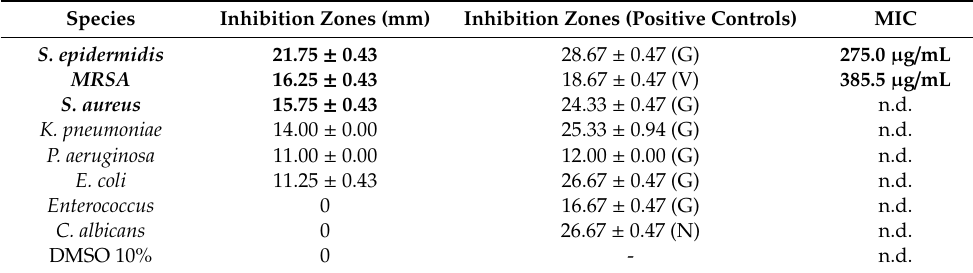
Table 4. Antimicrobial screening of C. collinum ethanolic leaves extract (CCL EtOH 50%, 10 mg / mL) and positive controls. Species Inhibition Zones (mm)